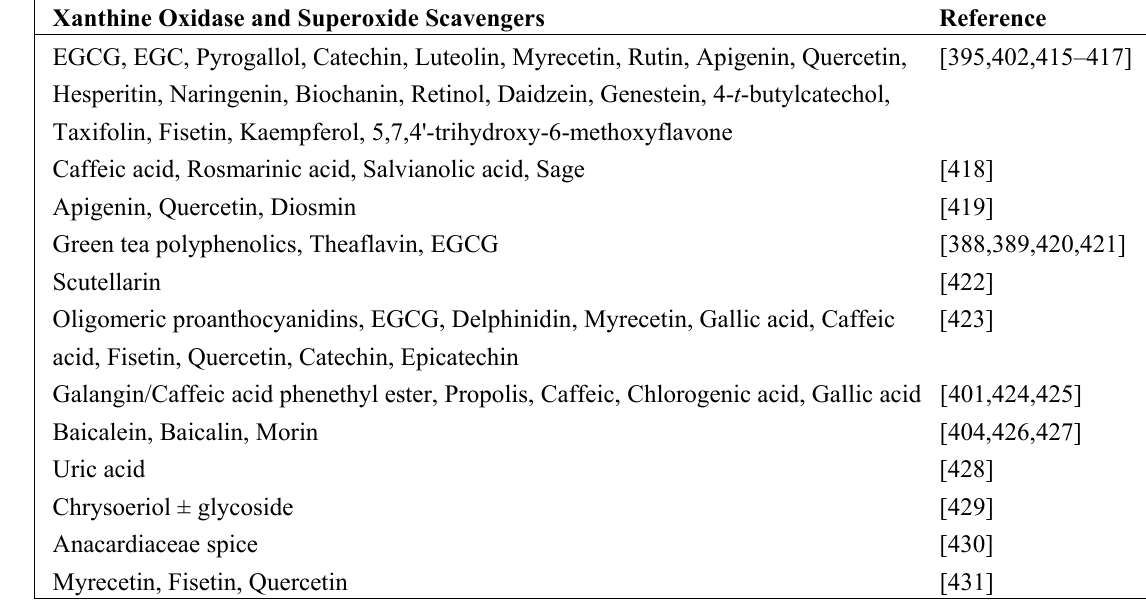
Table 6. Xanthine Oxidase and Superoxide